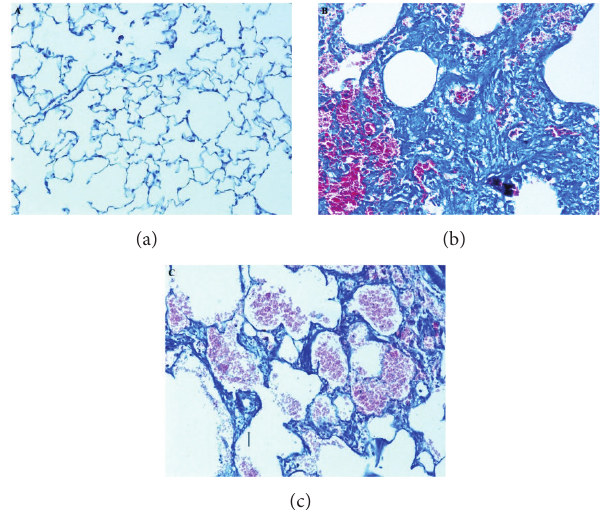
Figure 6: (Masson’s trichrome staining.) (a) Normal histoarchitec- ture of lung 200x. (b) Bleomycin-treated lung showing excessive collagen deposition leading to septal thickening and compressed alveoli 200x. (c) Quercetin-treated lungs showing mild to moderate collagen deposition